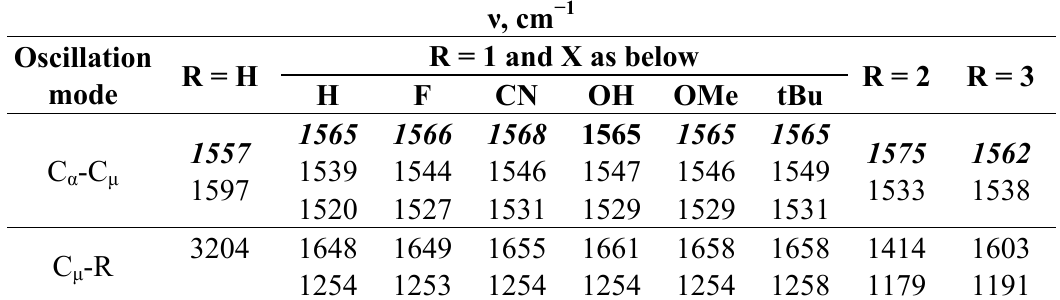
Table 3. Calculated frequencies ( ν ) of IR stretching vibrations (not scaled) assigned to the C -C -C bridges and (tentatively) to C α μ α Zn-porphyrins (according to Figure 1). The first-row frequencies ( bold italic font) apply to coupled diverse vibration modes, C Information appendix).